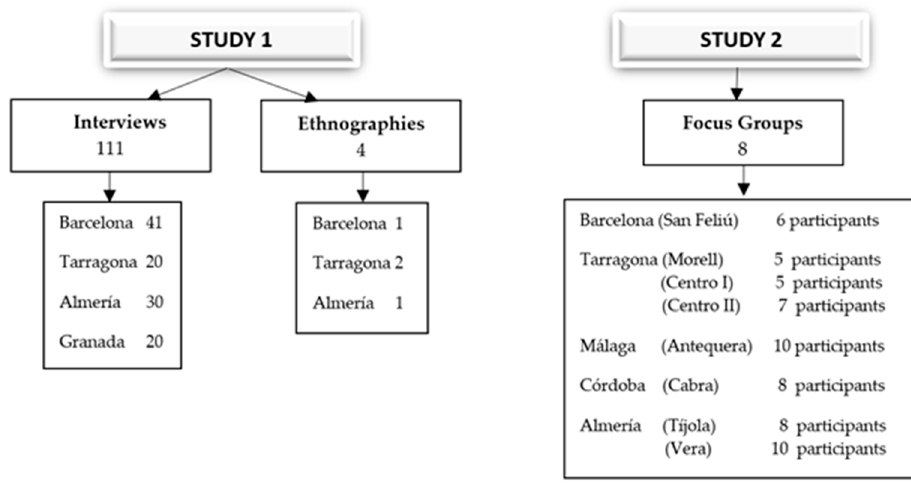
Figure 1. Data collection instruments by field work